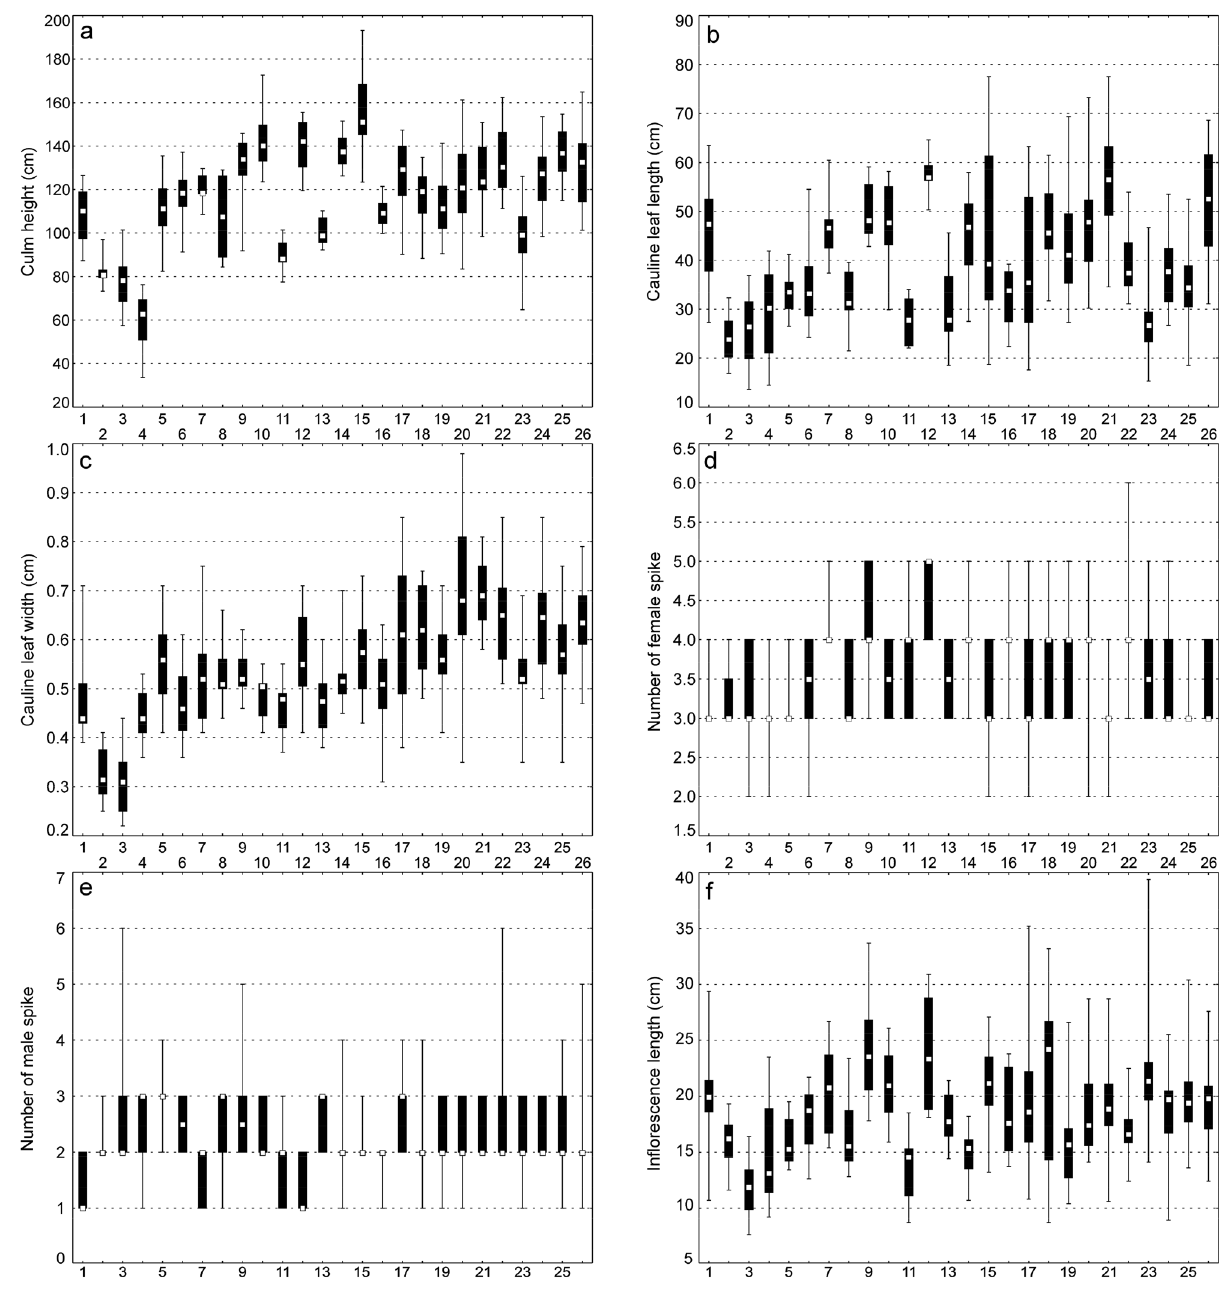
Figure 2. Ranges of morphological traits of Carex buekii populations. Large boxes indicate 25–75% of the interquartile ranges; small boxes represent medians; 1, 2, 3 ….26 are population numbers. The populations are numbered as in Table